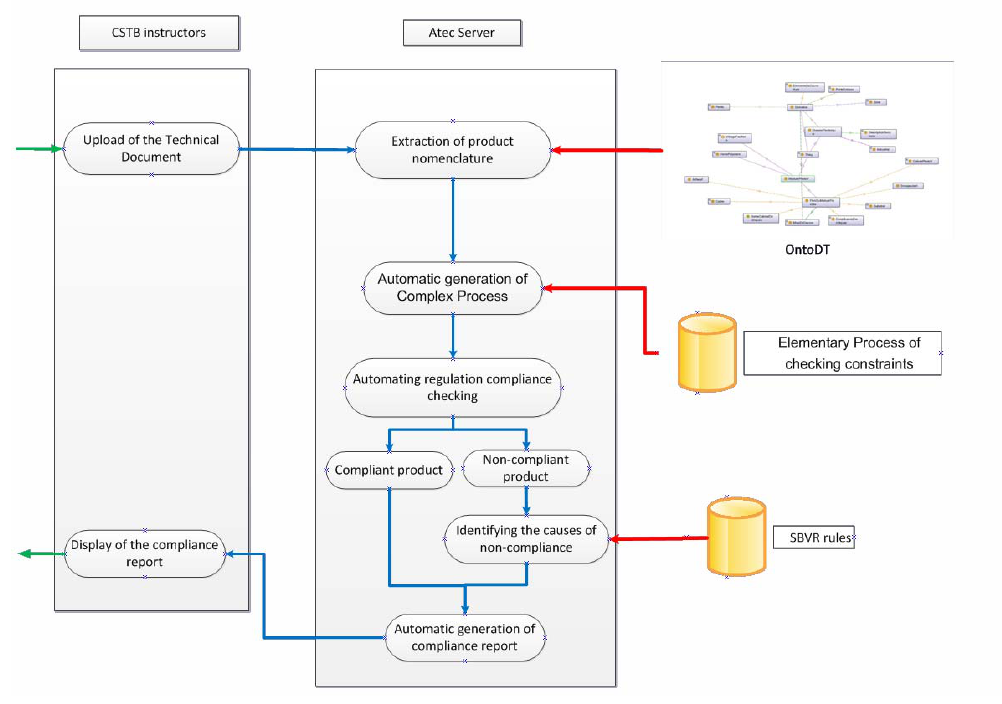
Figure 15. Overview of our assistant tool for writing technical